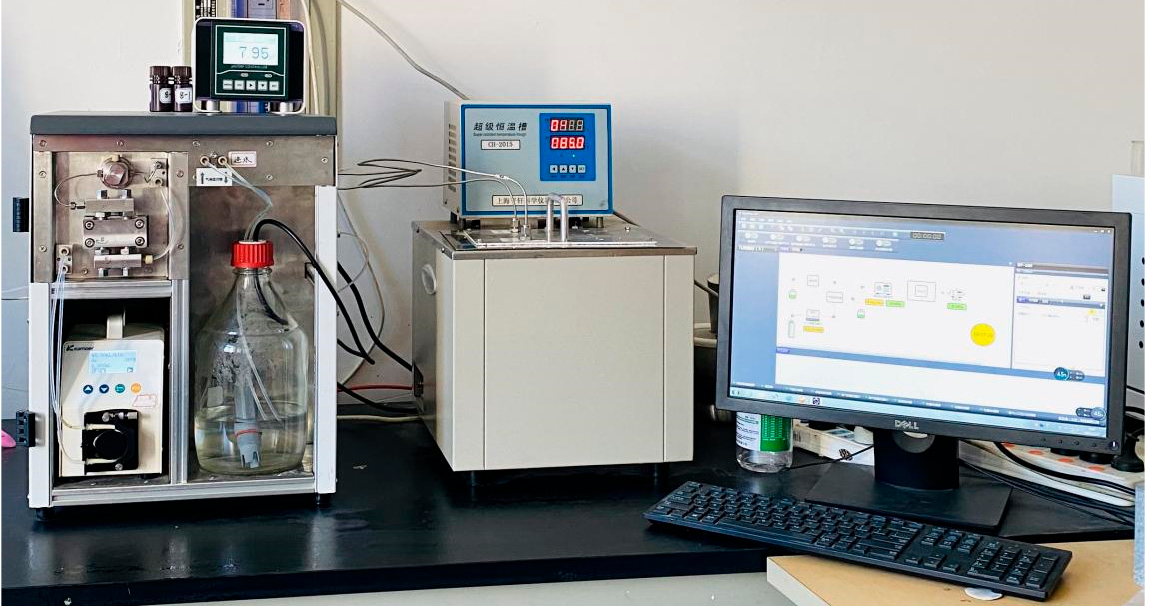
Figure 1. Self-made YDYR-2 rock hydrodynamic pressure dissolution test equipment.